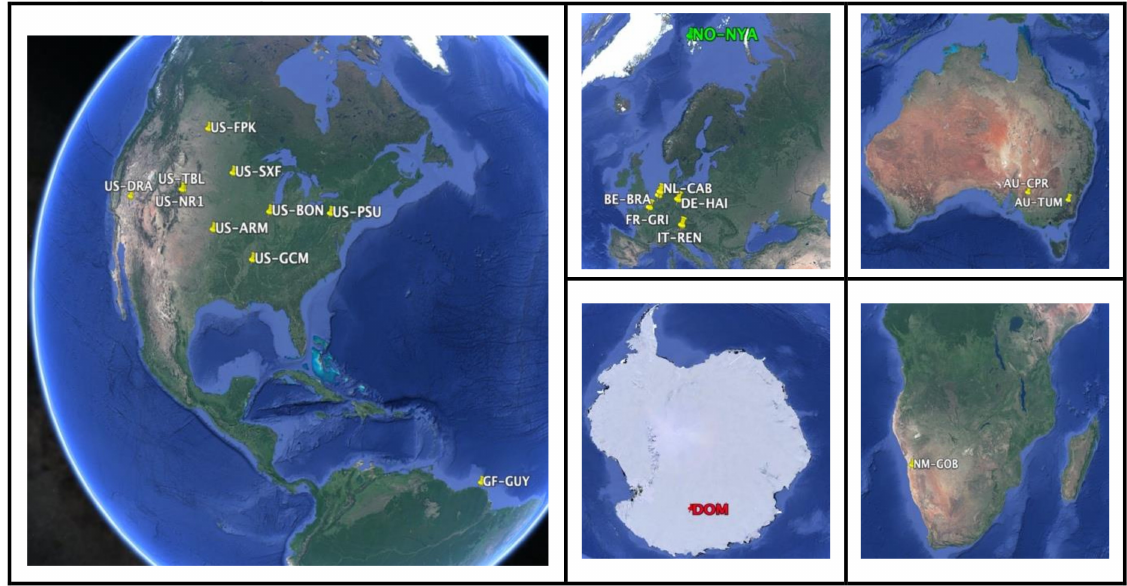
Figure 1. Geographical distribution of selected sites (Google